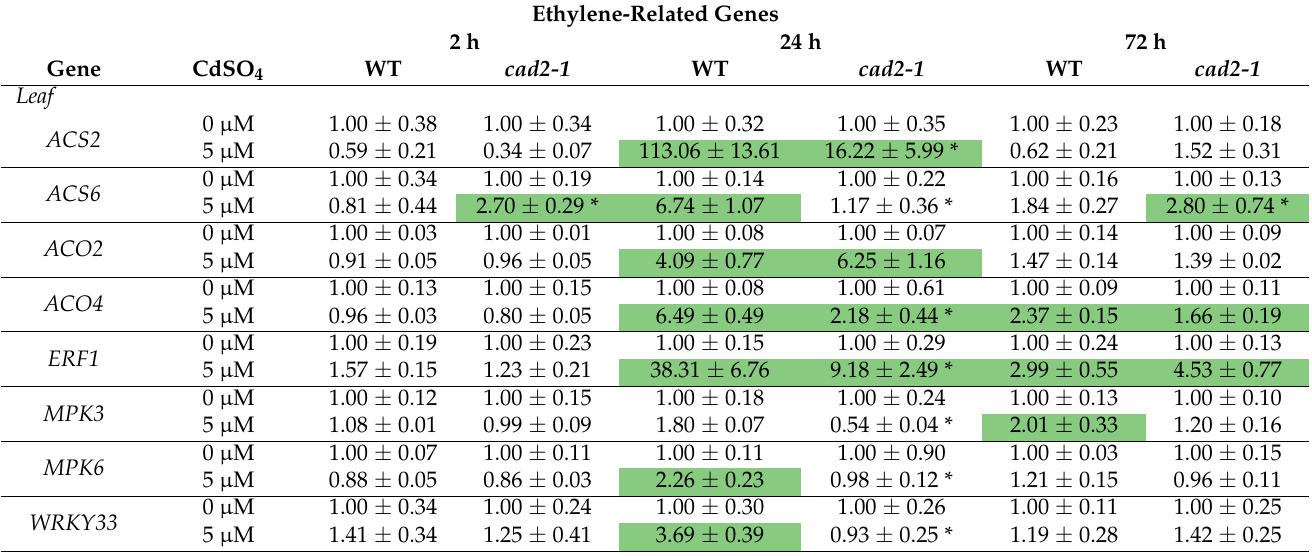
Table 4. Relative gene expression levels of ethylene-related genes in leaves and roots of 3-week-old wild-type (WT) and cad2-1 mutant Arabidopsis thaliana plants grown under control conditions (0 µ M CdSO 4 ) or exposed to 5 µ M CdSO 4 during 2 h, 24 h, and 72 h. Data are presented as the mean ± S.E. of at least three biological independent replicates relative to the control of the corresponding genotype set at 1.00. Significant differences (2-way ANOVA: p < 0.05) between control and Cd-exposed plants of the same genotype within each time point are marked in colour (upregulated: aa ). Significant differences between Cd-induced responses of both genotypes within each time point are indicated with an asterisk (*). ACS : ACC synthase, ACO : ACC oxidase, ERF1 : ethylene response factor 1, OXI1 : oxidative signal inducible 1, MPK : mitogen-activated protein kinase, WRKY33 : WRKY DNA-binding protein